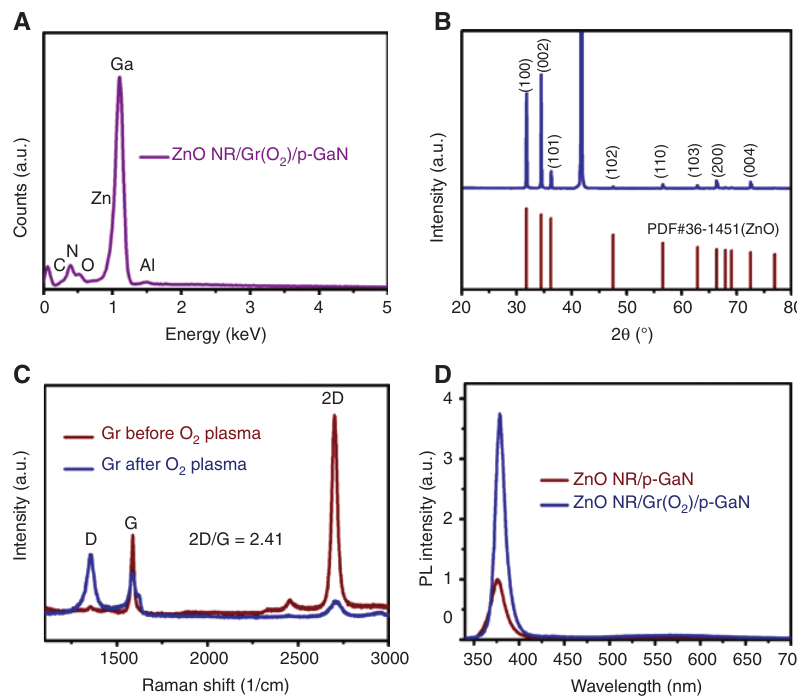
Figure 3: The structure and optical properties in both devices. (A) EDX pattern collected from the graphene-decorated ZnO NR array/p-GaN. (B) XRD pattern of graphene-decorated ZnO NR prepared on a p-GaN substrate. The curve at the bottom is the standard Powder Diffraction File (PDF) card for ZnO lattice structure. (C) Raman characterization of a graphene plasmon layer before (red curve) and after (blue curve) oxygen plasma treatment. (D) PL measurement of ZnO NR array/p-GaN without (red line) and with (blue line) graphene plasmon layer